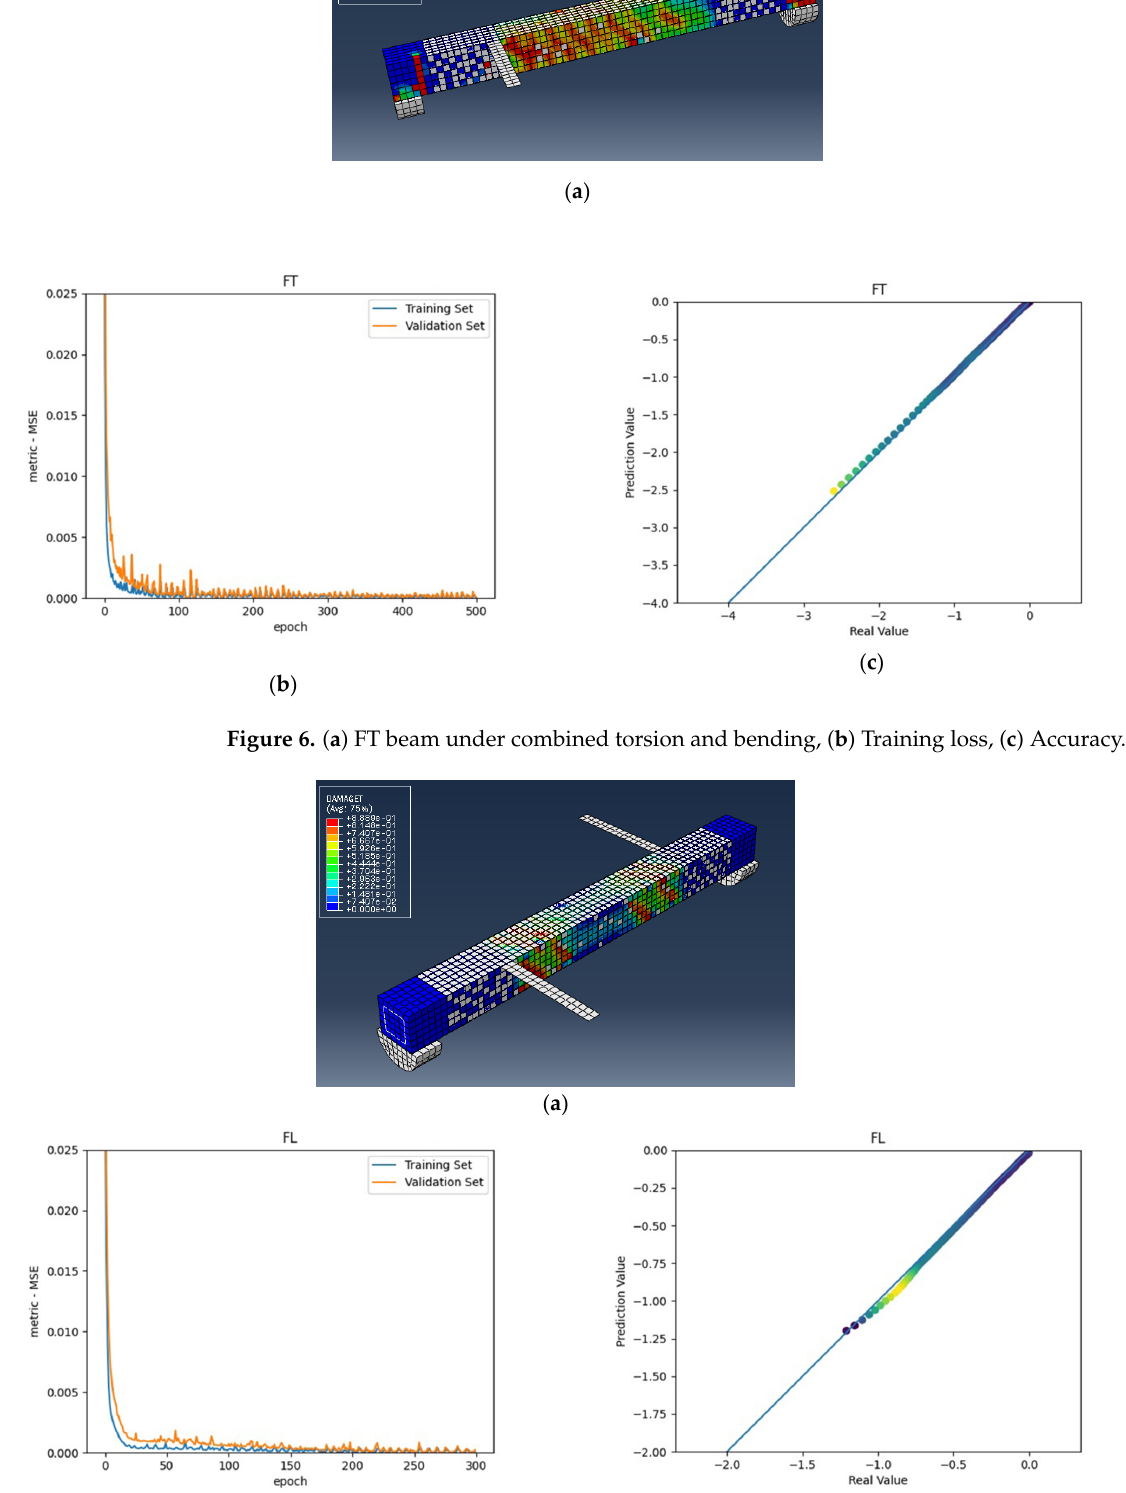
( c ) Figure 8. ( a ) 100s100 beam under combined torsion and bending, ( b ) Training loss, ( c ) Accuracy.